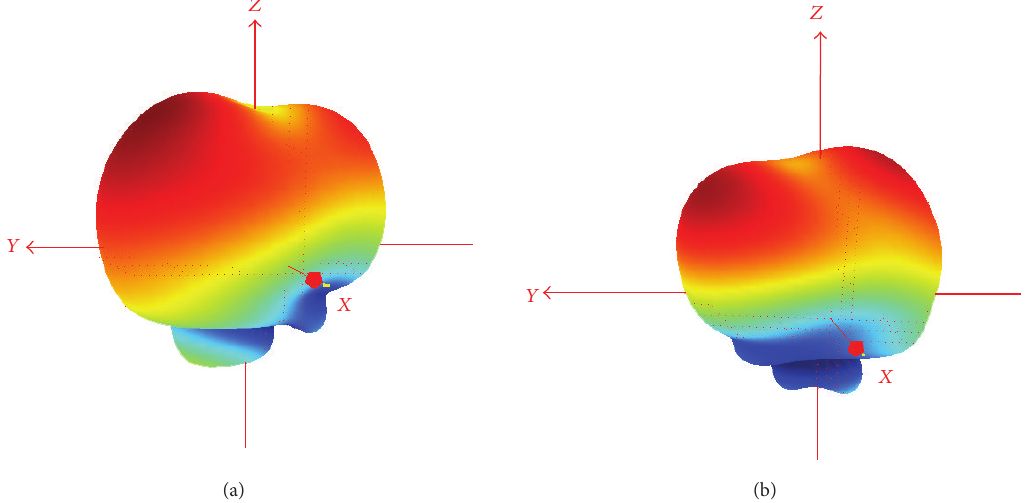
Figure 12: Measured 3D radiation patterns of the studied antenna at the operating frequency 𝐹 𝑅 and for the coupling distance 𝑑 1 : (a)